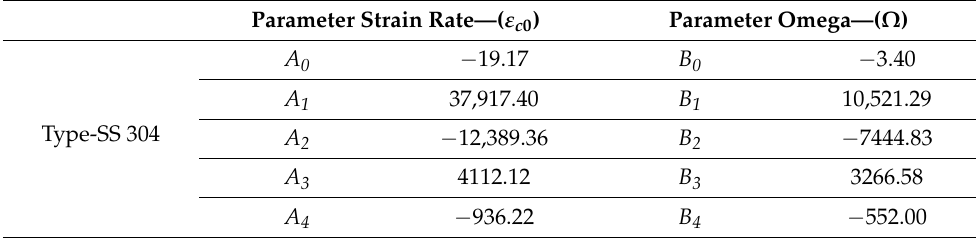
Table 1. Material coefficients for the SS-304 material type from MPC Omega (MPa, ◦ C)